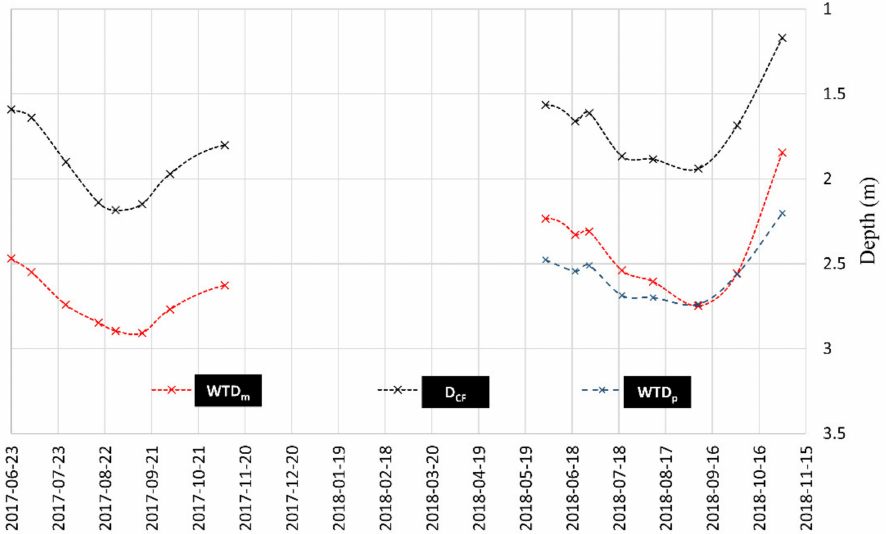
Figure 8. Temporal variability of the measured water table depth (WTD m ) and the estimated depth to the capillary fringe (D CF ) using ground penetrating radar (GPR) for both years, and the predicted water table depth (WTD p ) for